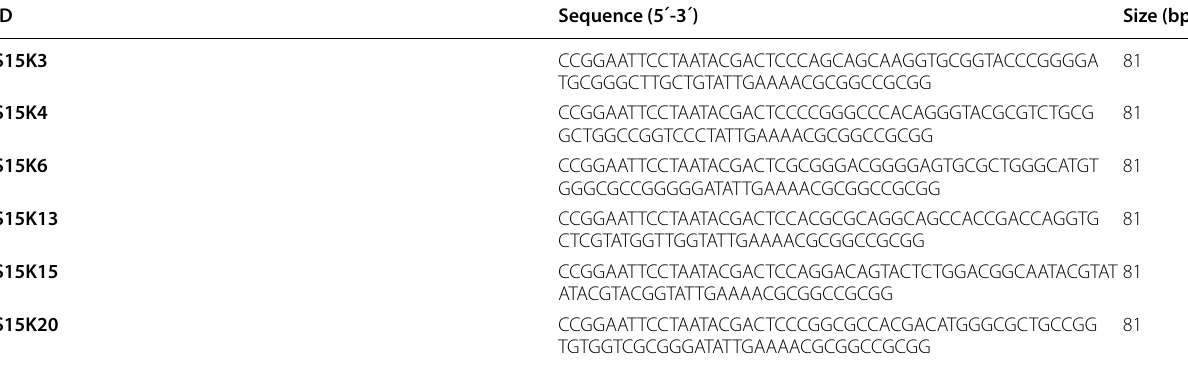
Table 1 ssDNA aptamer sequences isolated using the STC-SELEX process ID